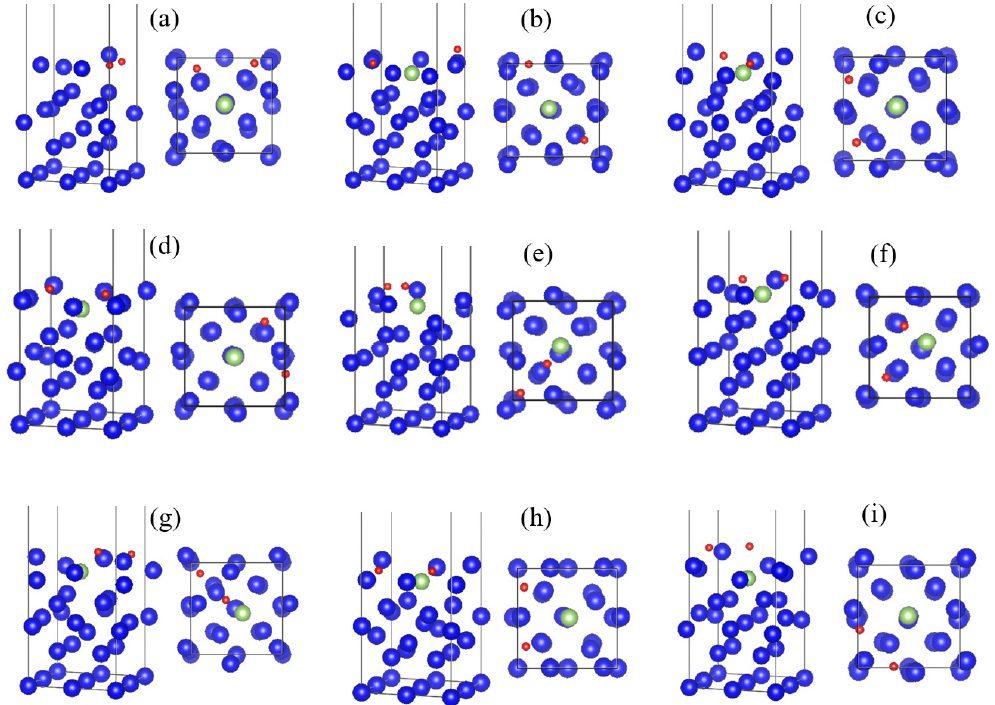
Figure 3. Stable adsorption configuration of O 2 on the surface of plutonium gallium system after optimization: ( a ) O-t-hor1, ( b ) O-h-hor1, ( c ) O-b-hor1, ( d ) O-t-hor2, ( e ) O-h-hor2, ( f ) O-b-hor2, ( g ) O-t-ver, ( h ) O-h-ver, ( i ) O-b-ver.